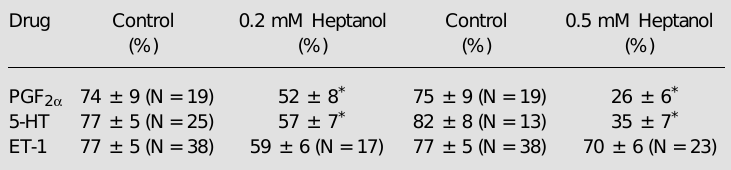
Figure 2 - Graphic depiction of heptanol-induced alterations in agonist-induced contractions. Shown are the mean ± SEM re- sponses observed under the fol- lowing conditions: Panel A ,,,,, Con- trol ET-1-induced contractile re- sponse (20 nM), and the re- sponse observed following pre- incubation with 0.2 and 0.5 mM heptanol, respectively (see Ma- terial and Methods for details). In Panel B (5-HT; 1-2 µM) and Panel C (PGF 2 a ; 1 µM), , , , , C1 and C2 denote the paired time-de- pendent control response to two successive applications of agonist to the same aortic ring (see Material and Methods); C3 and 0.2 denote the paired re- sponses of the same aortic ring to the application of the same concentration of agonist on the same ring in the absence (C3) and presence (0.2) of 0.2 mM heptanol; C4 and 0.5 denote the paired responses of the same aortic ring to the application of the same concentration of ago- nist on the same ring in the ab- sence (C4) and presence (0.5) of 0.5 mM heptanol. The num- ber of observations, statistical significance levels and actual values for all agonists are dis- played in Table 1. For abbrevia- tions, see legend to Figure 1.